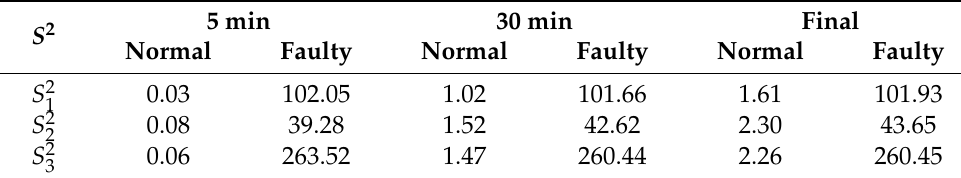
Table 6. Winding temperature variance statistics at each